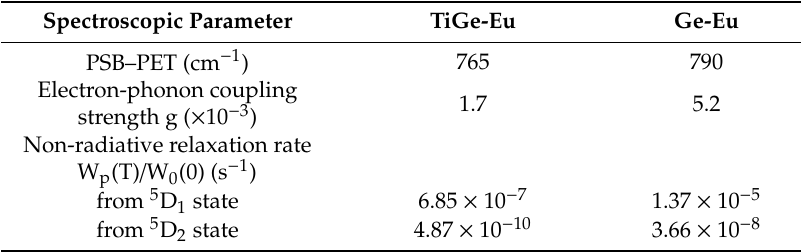
Figure 3. Excitation ( a ) and emission ( b ) spectra, and decay curves ( c ) for titanate-germanate glasses doped with europium ions (TiGe-Eu) and compared to glass samples without TiO 2 (Ge-Eu). All changes are also schematized ( d – f ). Table 2. Spectroscopic parameters for europium ions in glasses TiGe-Eu and Ge-Eu.